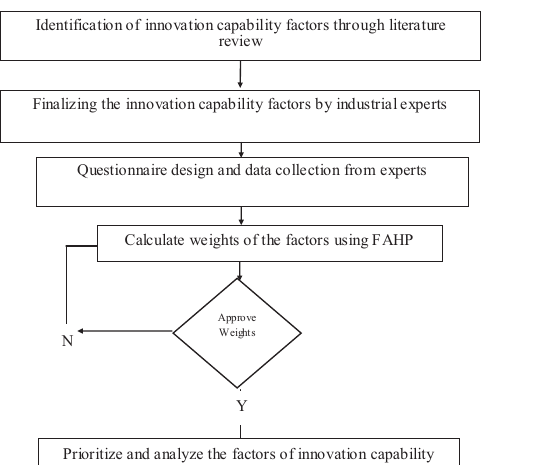
Figure 1. Proposed